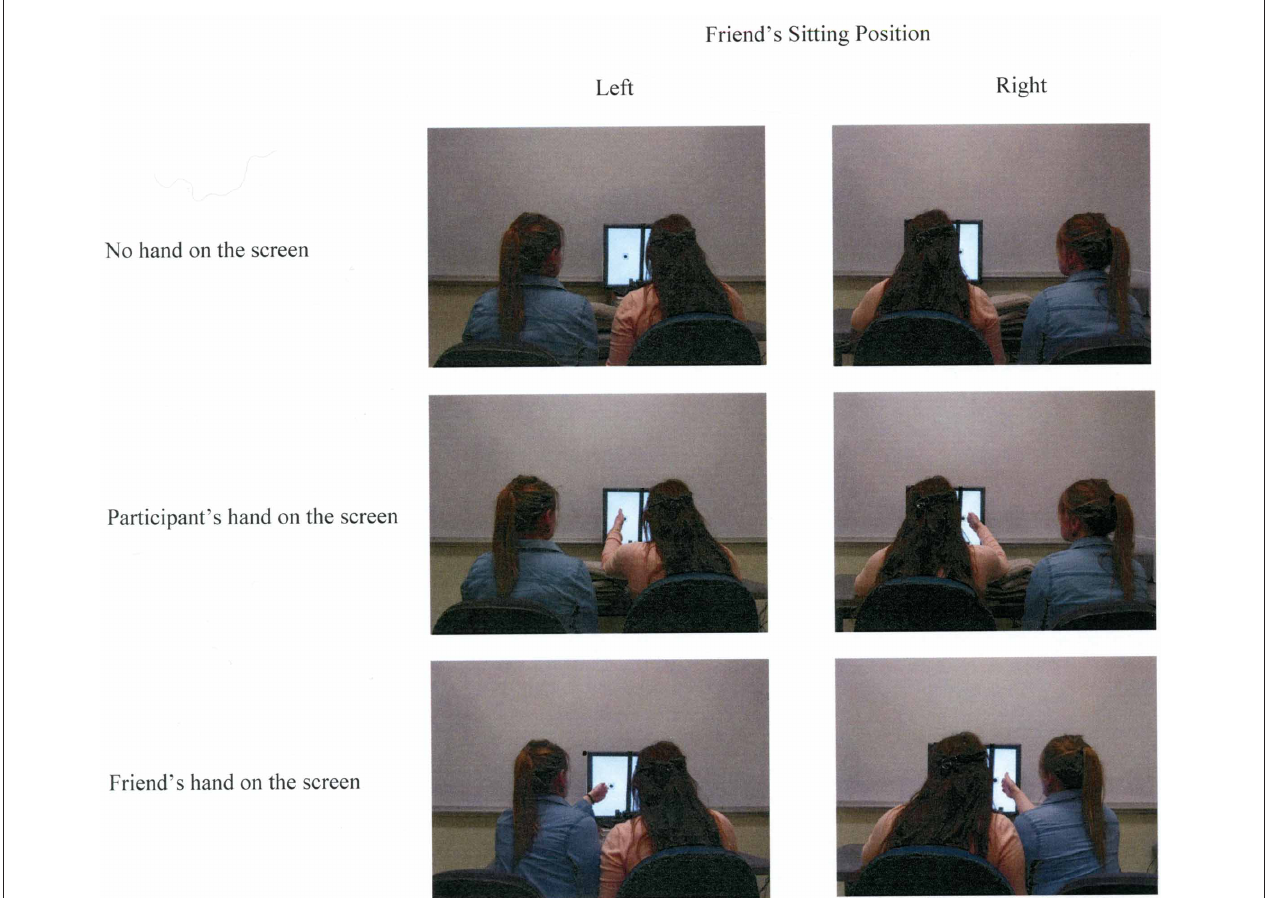
FIGURE 2 | Experimental setup and hand positions in Experiment